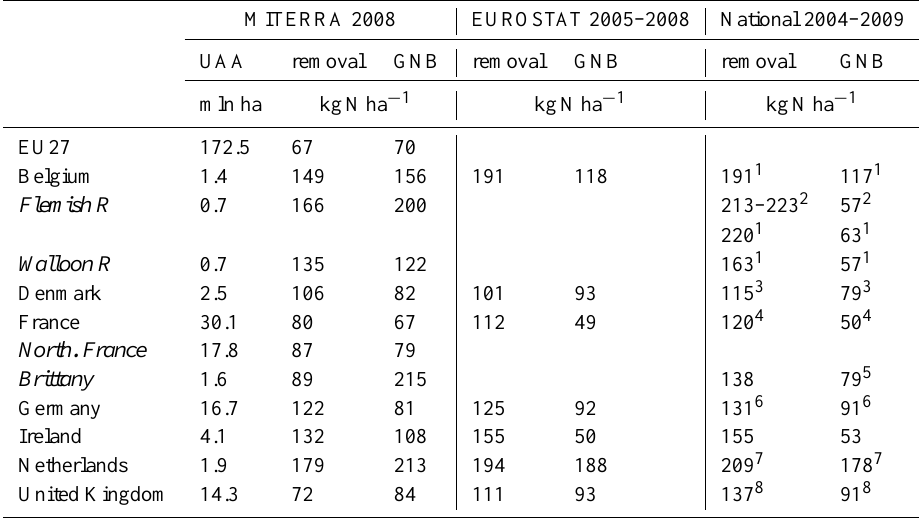
Table 12. Annual N removal, and gross N balance (GNB) by MITERRA in 2008, compared to values in Eurostat and national reports in the period